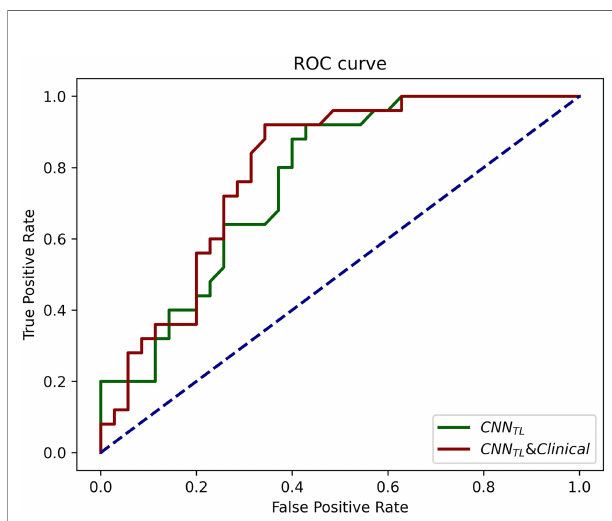
FIGURE 5 | The ROCs of CNN TL (transferred from the EGFR classi fi cation) and the CNN TL and clinical models for progression patterns prediction in the validation group. The corresponding AUCs were 0.76 and